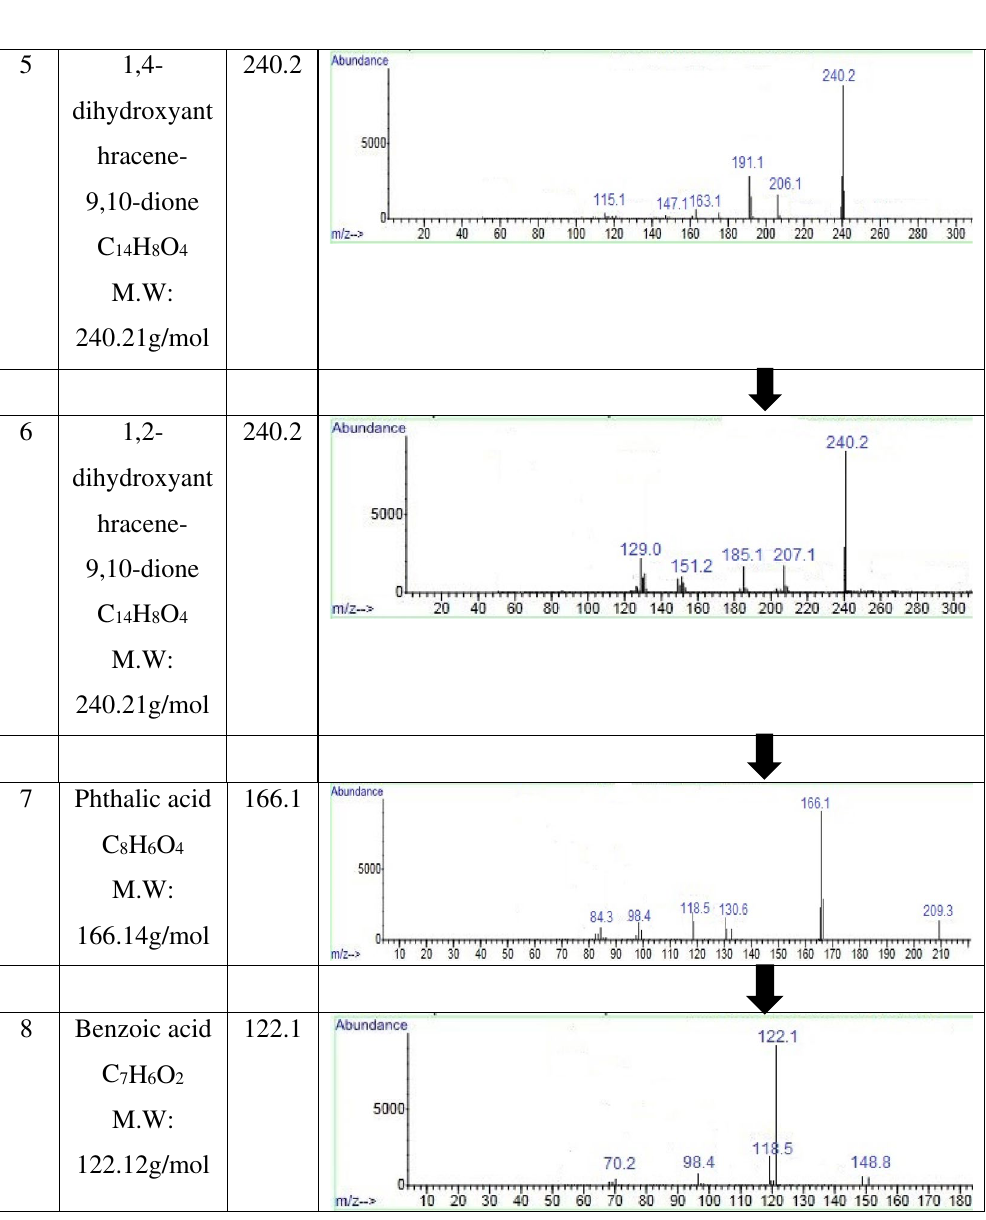
Table 4. Compounds involved in the metabolic pathway of Indanthrene Blue RS degradation towards mineralization by consortium-BP, identified by GC–MS